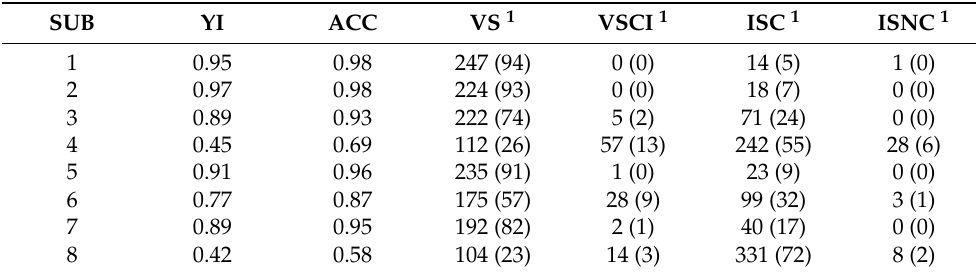
Table 3. System performance during target